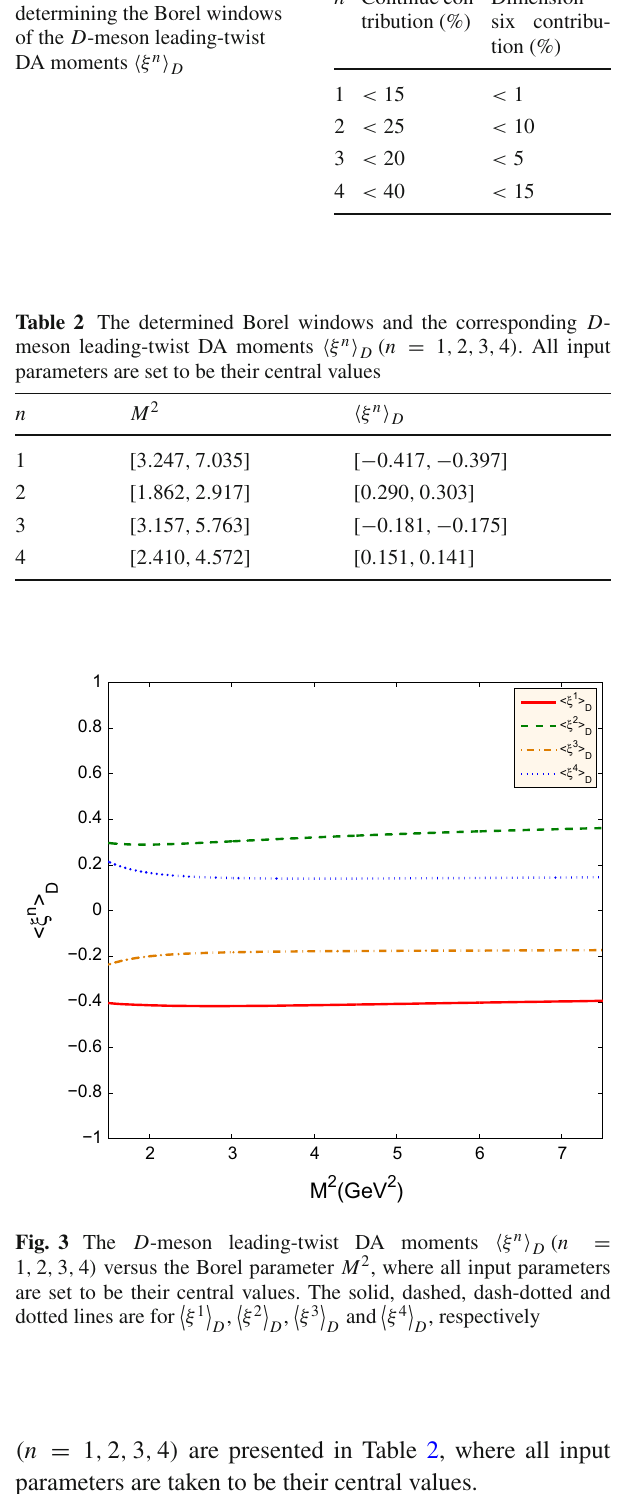
( n = 1 , 2 , 3 , 4 ) are presented in Table 2, where all input parameters are taken to be their central